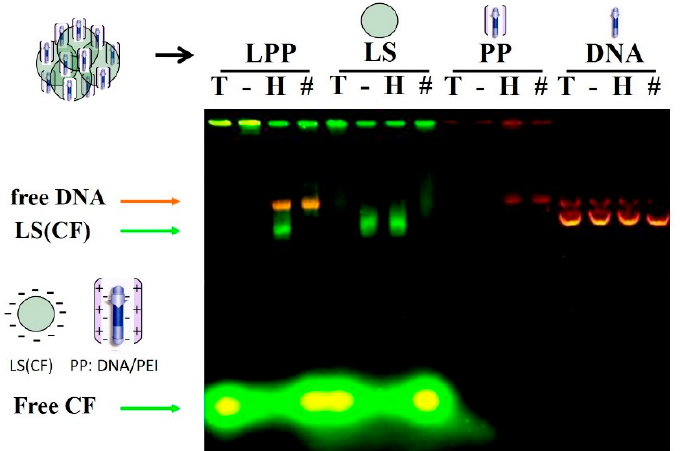
Figure 2. Characterization of the lipopolyplex by electrophoretic mobility shift assay (EMSA) assay. Triton X-100 (T), glucose 5% (-), heparin (H), or Triton X-100 plus heparin (#) were added to samples of lipopolyplex (lanes 1–4), liposomes (lanes 5–8), polyplex (lanes 9–12), and free plasmid p3C-EGFP (lanes 13–16) were added before loading on the gel. Electrophoresis ran at 80mV for